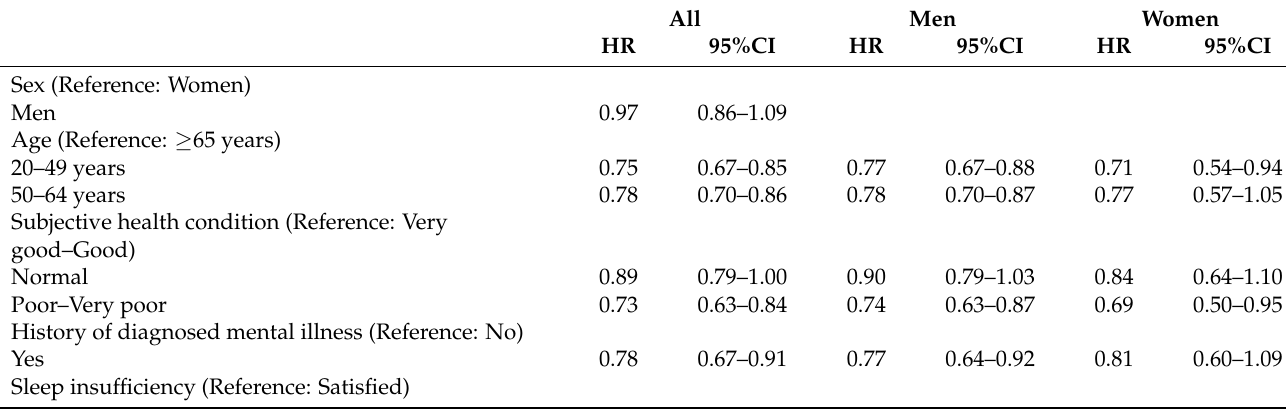
Table 5. Crude HRs and 95% CIs for recovery from problem drinking from FY 2012 to FY 2017.